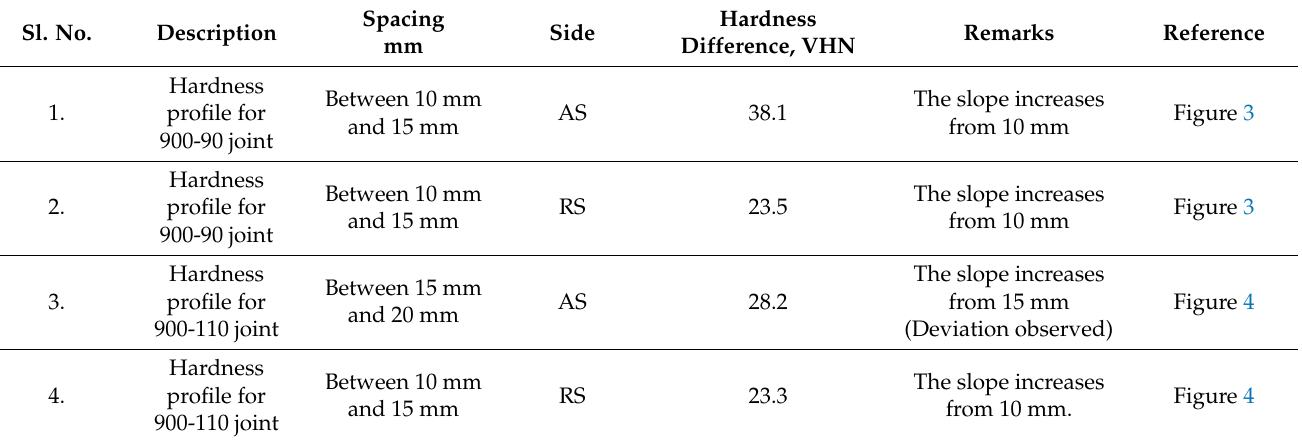
Figure 4. Hardness map for 900-110 joint. X–Hardness transition point. Table 4. Hardness variation table in the vicinity of heat affected zone